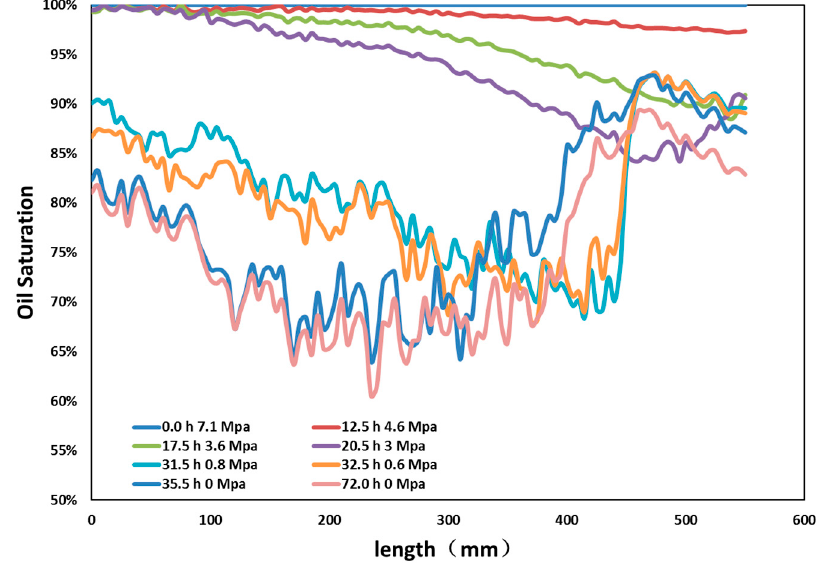
Figure 13. Oil saturation distribution curves in Experiment 5.